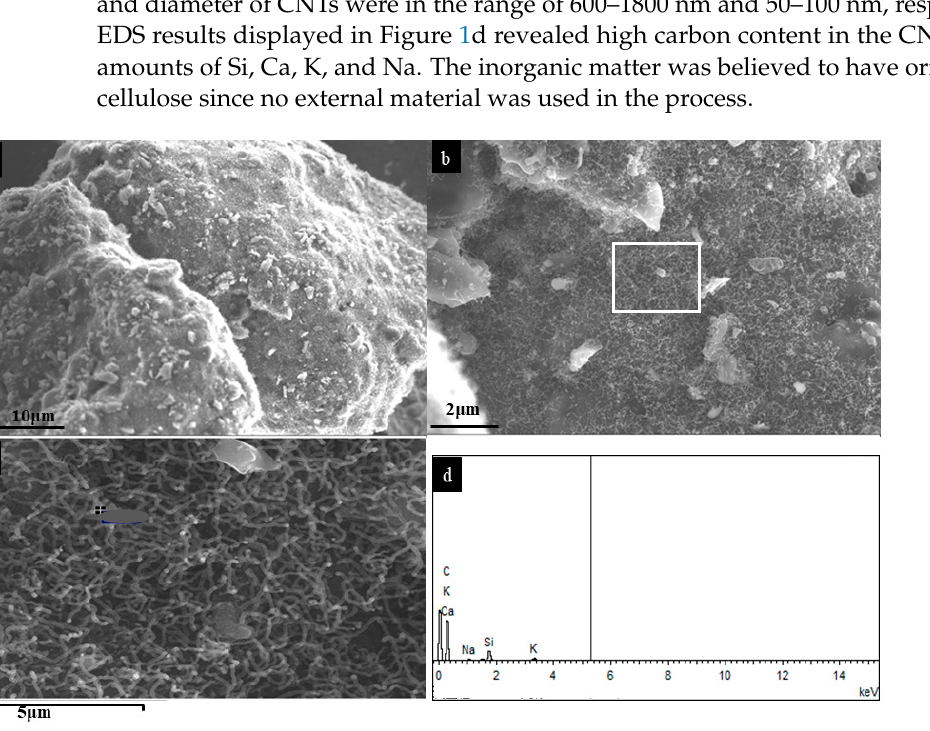
Figure 1. SEM of ( a ) grown CNTs at 600 ◦ C, ( b ) magnified image, ( c ) magnified image of marked section in ( b ), ( d ) EDS spectra from ( c )